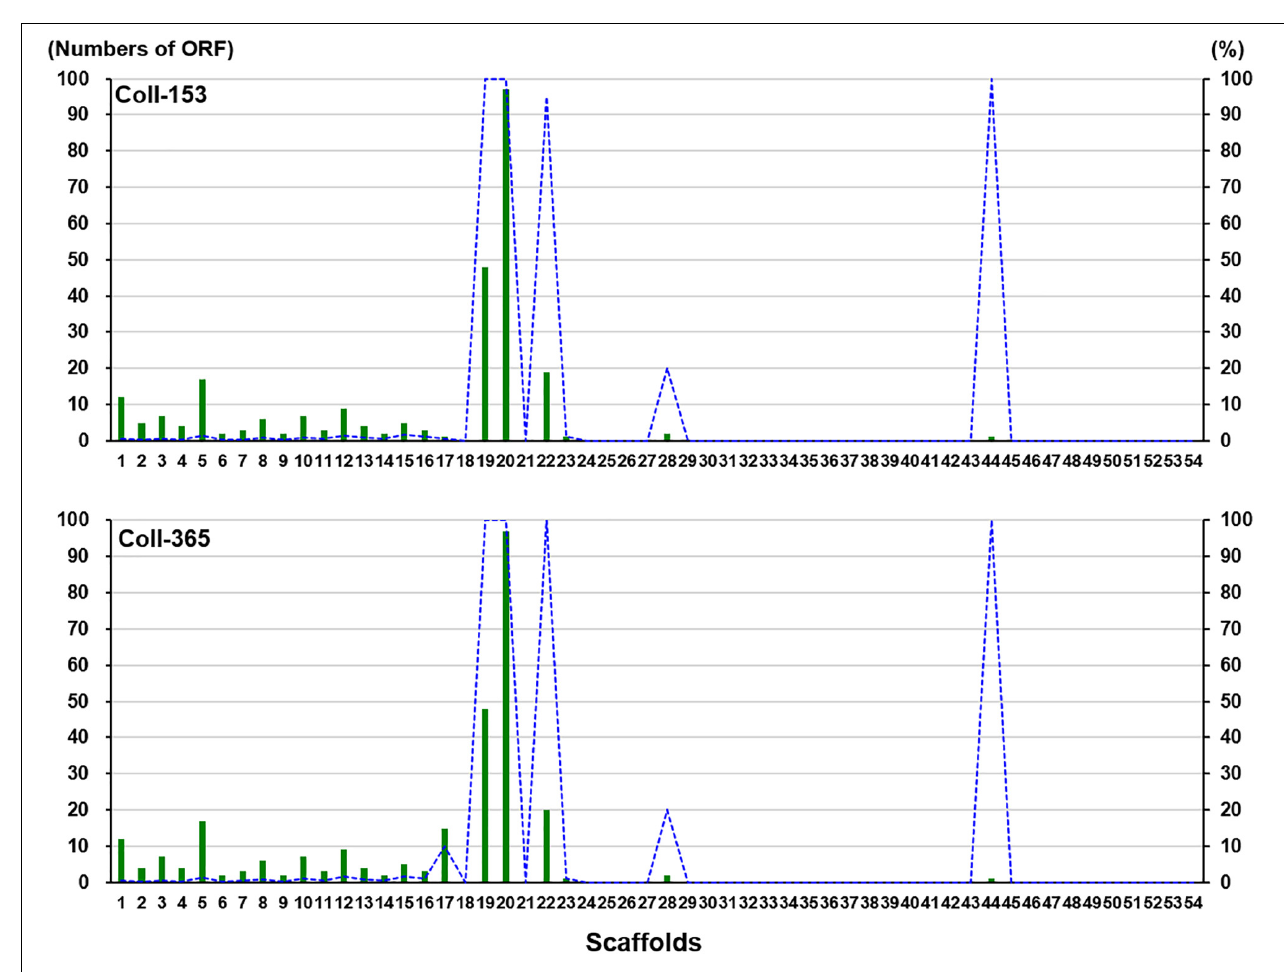
FIGURE 4 | ORF-Vrem in strains Coll-153 and Coll-365 compared to strain Coll-524 in each scaffold. Total ORF-Vrem in each scaffold were indicated as green bars. The percentage of ORF-Vrem in each scaffold by comparing with ORFs of Coll-524 in each scaffold was indicated with blue